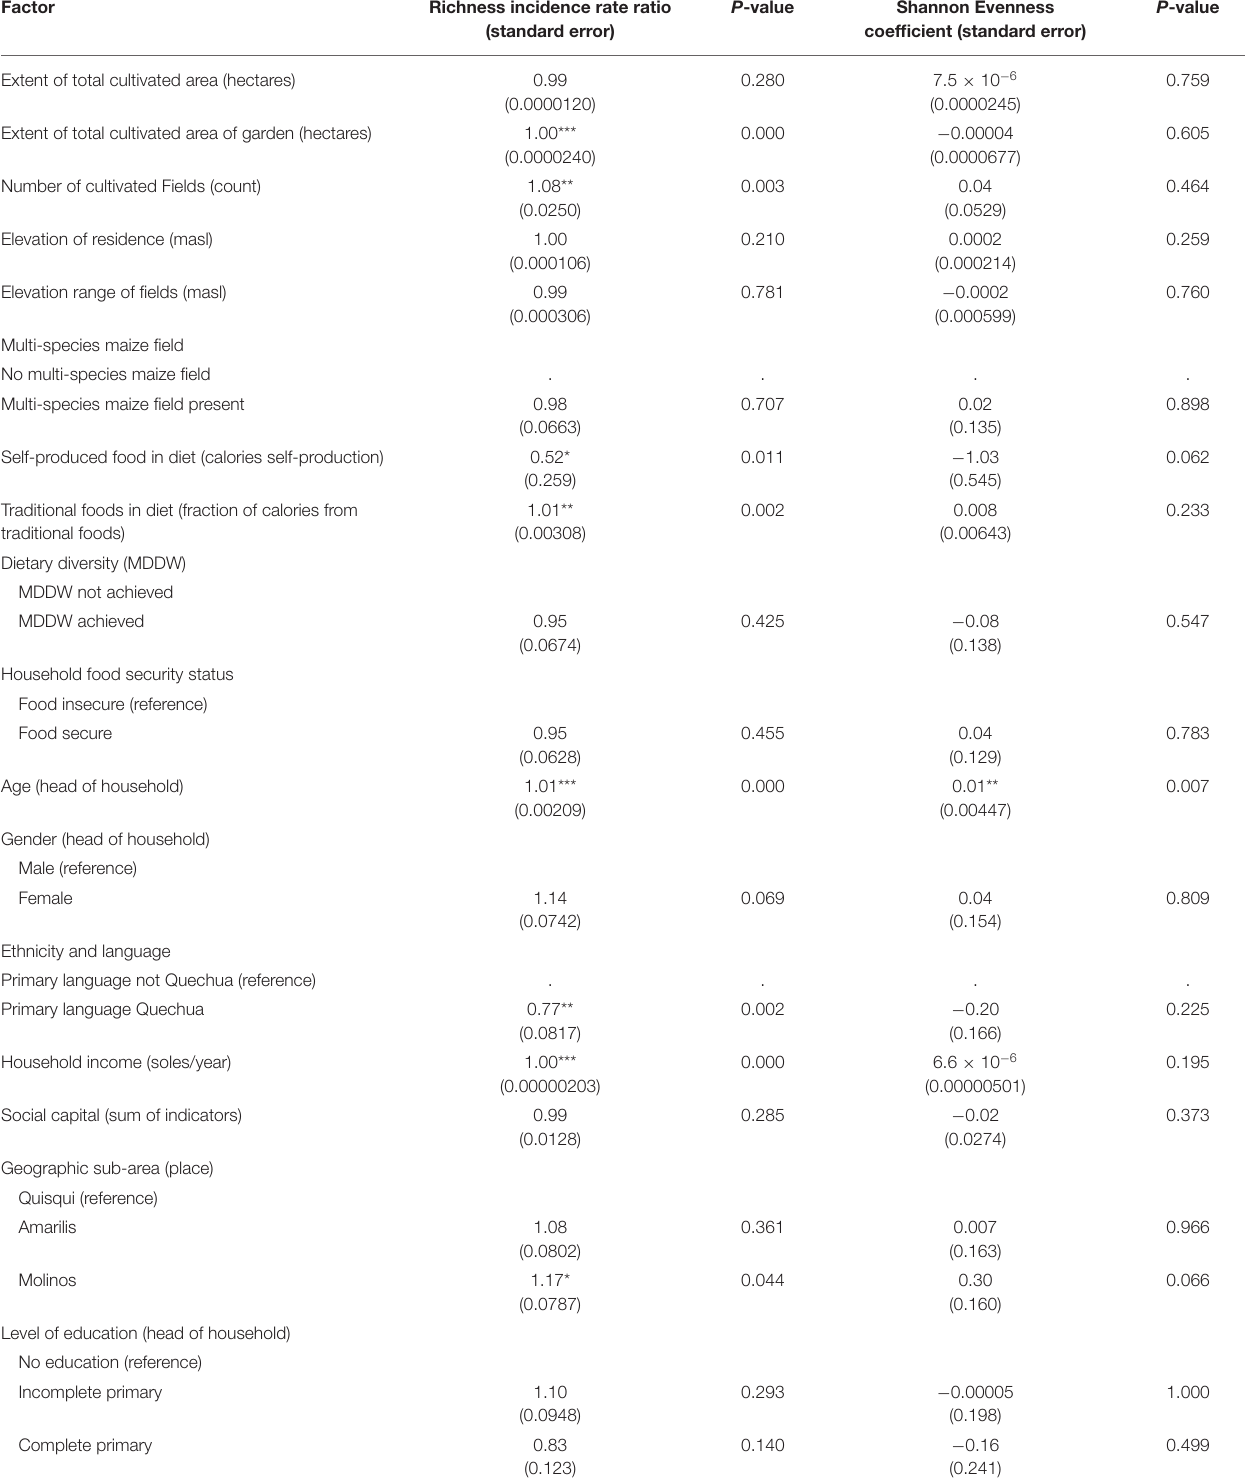
TABLE 4 | Results of multiple regression analyses of the associations of social-ecological and political-ecological factors with managed species agrobiodiversity in gardens ( Huertos , Huertas ).